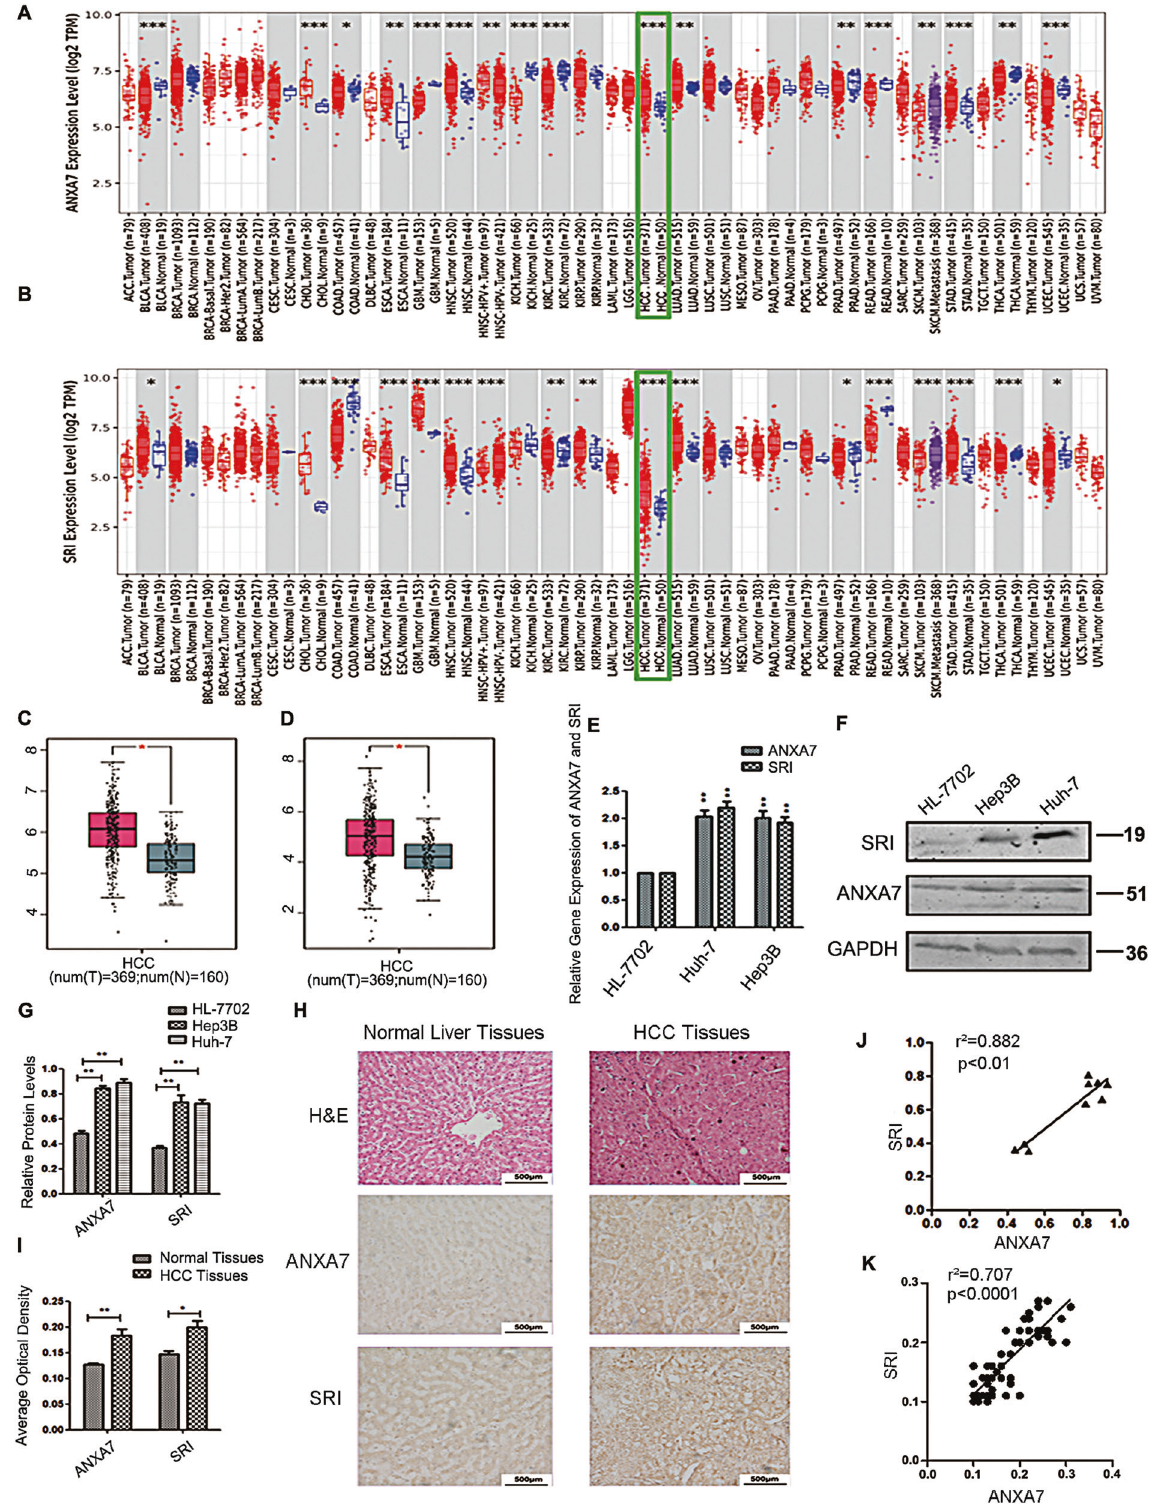
Fig. 1 The expression of ANXA7 and SRI and the positive correlation between them in HCC. A , B The expression of ANXA7 and SRI in different cancers or speci fi c cancer subtypes was analyzed through TIMER2. The expression of ANXA7 and SRI in HCC are higher ( n = 371) than normal liver tissues ( n = 50) (*** p <0.001). C , D The expression of ANXA7 is higher in HCC ( n = 369) than in normal liver tissues ( n = 160) from the TCGA database. The expression of SRI is also higher in HCC ( n = 369) than in normal liver tissues ( n = 160) from the TCGA database ( * p < 0.05). E – G The expression of ANXA7 and SRI were higher in Huh-7/Hep3B cells than in normal human hepatocytes HL-7702 by qRT-PCR and western blotting. H Representative images of ANXA7 and SRI expression in normal human liver tissues and HCC tissues. I Quanti fi cation of the average means optical density for ANXA7 and SRI in normal liver tissues and HCC tissues (** p < 0.01, * p <0.05). J ANXA7 expression level p ositively correlated with SRI expression in HCC cells ( r 2 = 0.882, p <0.01). K ANXA7 expression level positively correlated with SRI expression in HCC tissues ( r 2 = 0.707, p < 0.01). Cell Death and Disease (2021)